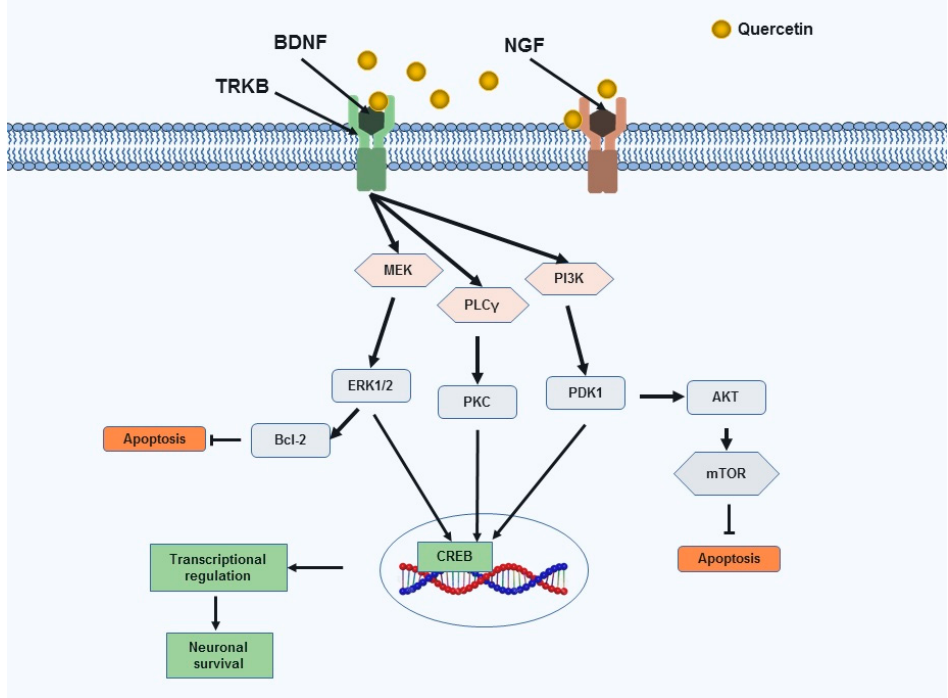
Figure 3. Molecular pathways regarding neuronal survival on which QC seems to assess their e ff ects within the brain. QC-mediated action on neurotrophic factors BDNF and NGF. QC activates BDNF-TrkB and its associated signaling pathway, which ultimately, results in phosphorylation of CREB, and the CREB-mediated neuronal survival e ff ect [101]. BDNF: Brain-derived neurotrophic factor; TRKB: Tropomyosin receptor kinase B; NGF: Nerve growth factor; PLC γ : Phospholipase C gamma; PI3K: Phosphatidylinositol 3-kinase; PKC: Protein kinase C; ERK: Extracellular signal-regulated kinase 1 / 2; PDK1: 3-phosphoinositide-dependent protein kinase 1; mTOR: Mammalian target of rapamycin; Akt: Protein Kinase B; Bcl-2: B-cell lymphoma 2; CREB: Cyclic AMP response element binding